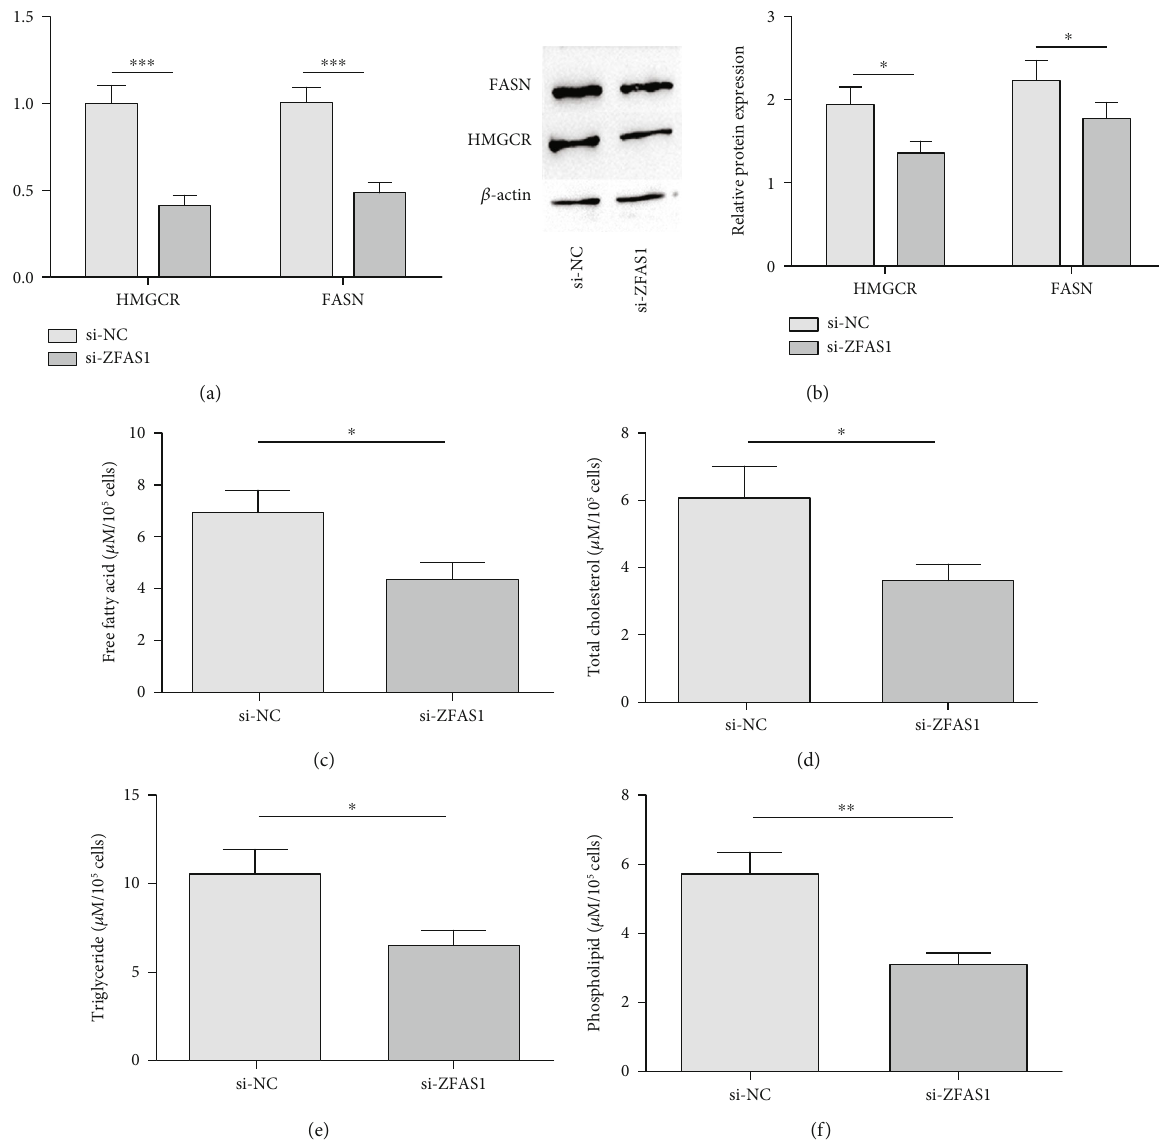
Figure 3: ZFAS1 participates in PC cell lipometabolism. (a) HMGCR mRNA expression; (b) HMGCR protein expression; (c) free fatty acid content in cells; (d) total cholesterol content in cells; (e) triglyceride content in cells; (f) phospholipid content in cells; ∗ P < 0 : 05 ; ∗∗ P < 0 : 01, and ∗∗∗ P < 0 : 001